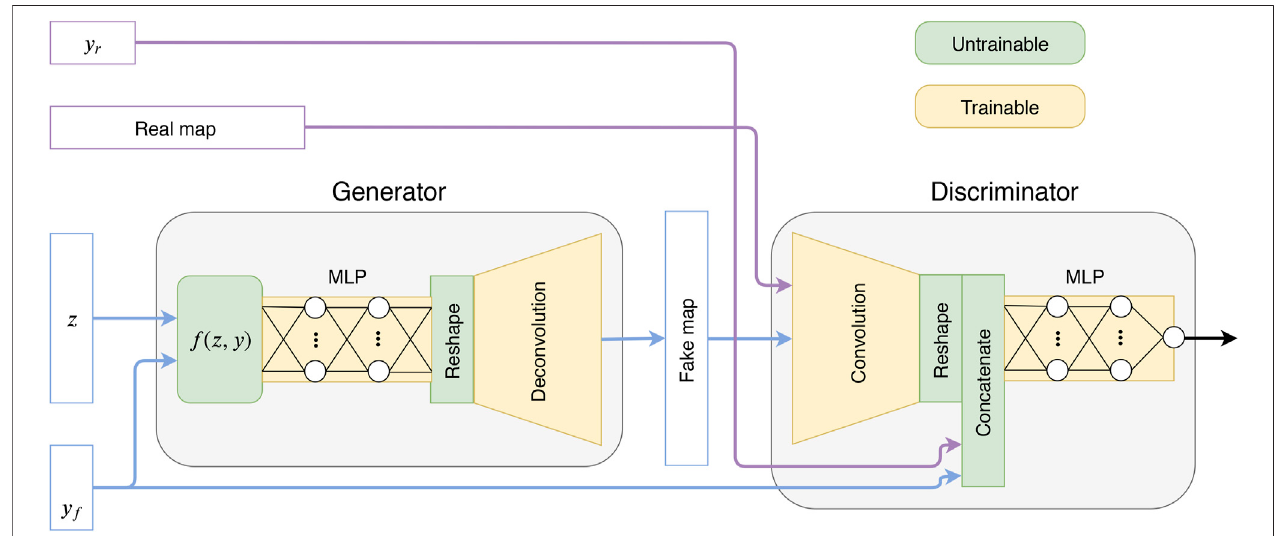
FIGURE 1 | Sketch of the proposed GAN model, where z is a latent variable and y is a parameter vector ( y r (cid:2) real, y f (cid:2) fake).